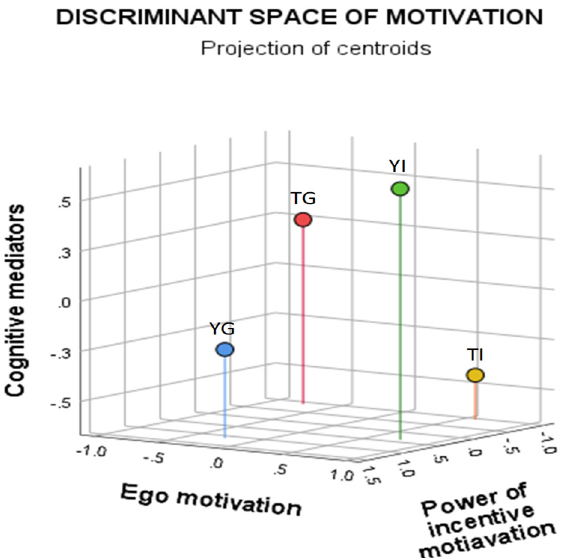
Figure 1. Projection of centroids for groups in 3-dimensional discriminant space of motivation.